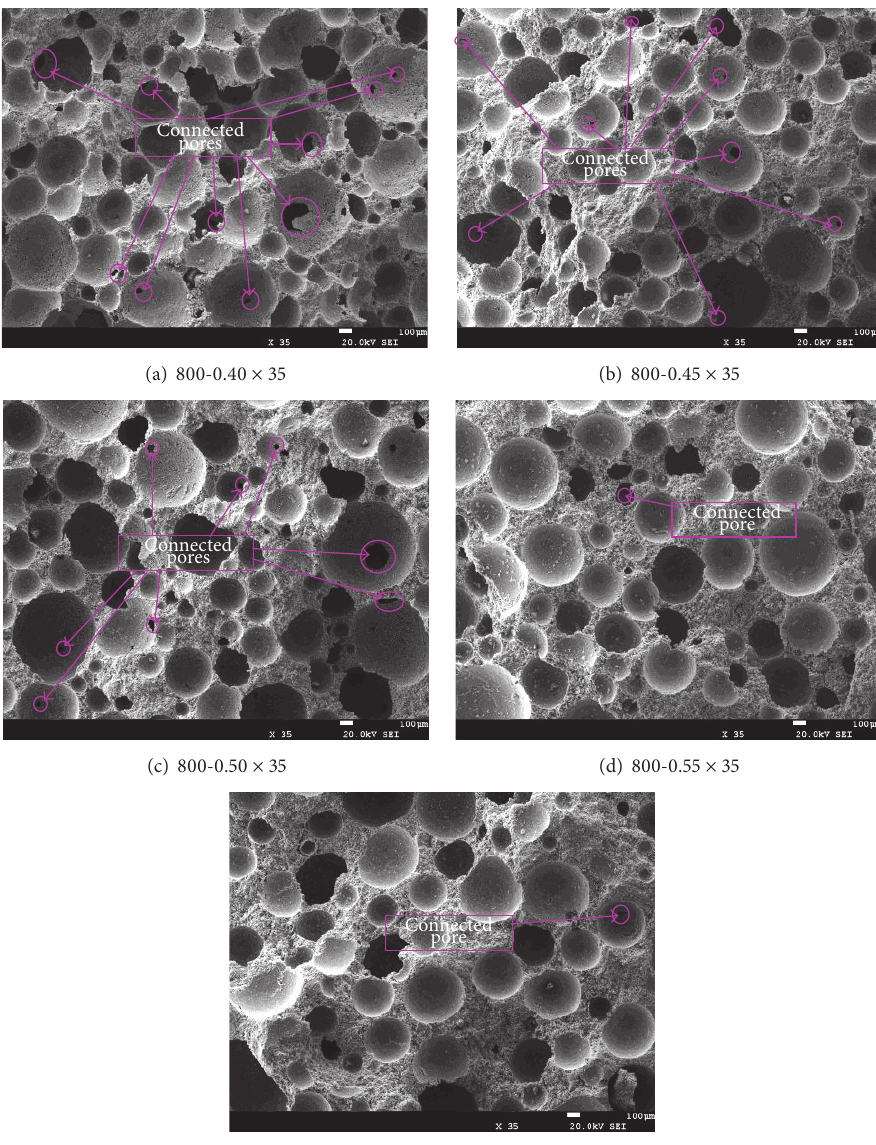
Figure 3: SEM images of the 800kg/m 3 foam concrete of different w/c